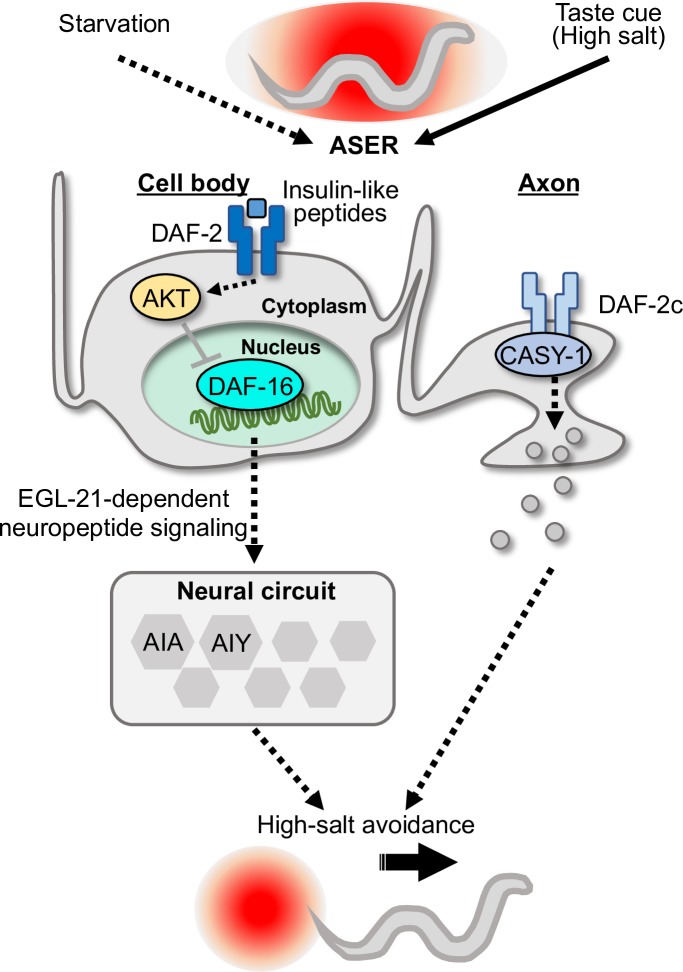
A summary of DAF-16 functions in taste avoidance learning.Animals avoid salt concentrations encountered during starvation and migrate to areas at lower and higher salt concentrations. To avoid high-salt areas, DAF-16 acts in the ASER cell body independently of axonal DAF-2c signaling. DAF-16 is translocated into the nucleus of ASER dependent on signaling mediated by DAF-2(exon 11.5-) isoforms and transmits the signal to downstream neurons, including AIA and AIY, via neuropeptide signaling modulated by EGL-21/carboxypeptidase E, and promotes high-salt avoidance.